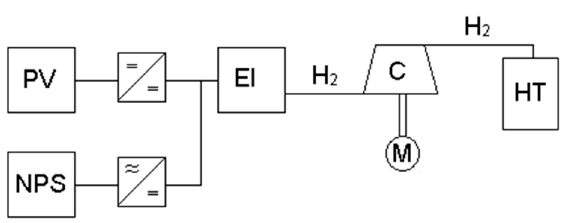
Figure 3. Flowchart: hydrogen production system (PV—photovoltaic installation) [9].